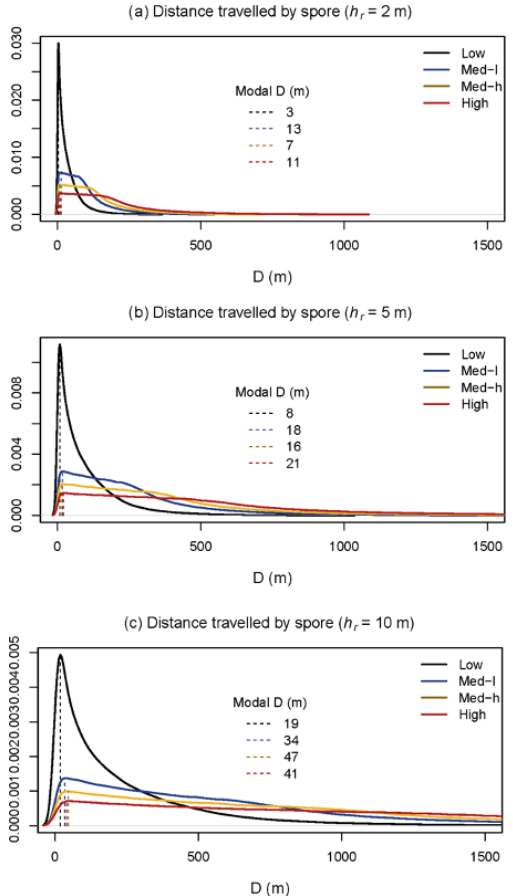
Figure 5. Model outputs of probability density functions for dis- tance travelled by spores in a forested environment. Panels (a) , (b) , and (c) had different spore release heights ( h r ) inputted into the model – 2, 5, and 10m, respectively. Solid lines are in different colours for each of the low (black), low–medium (blue), medium– high (yellow), and high (red) U h (wind speed) cases. Dashed lines c show modal D (distance) travelled by the spores. n = 1000000 for each